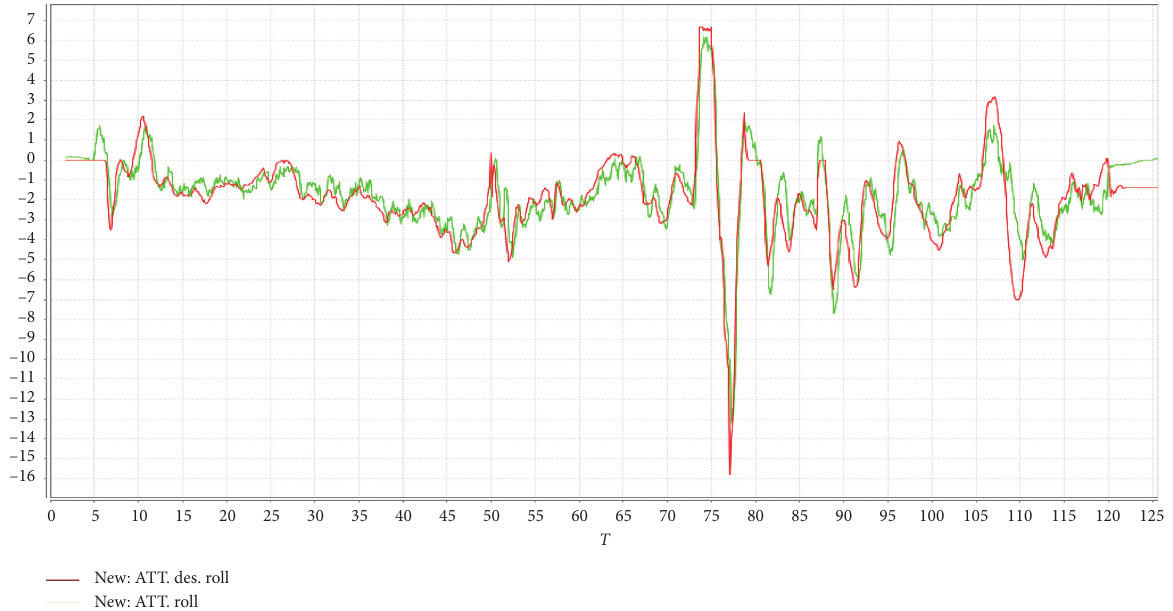
Figure 15: Actual flight roll angle graph.